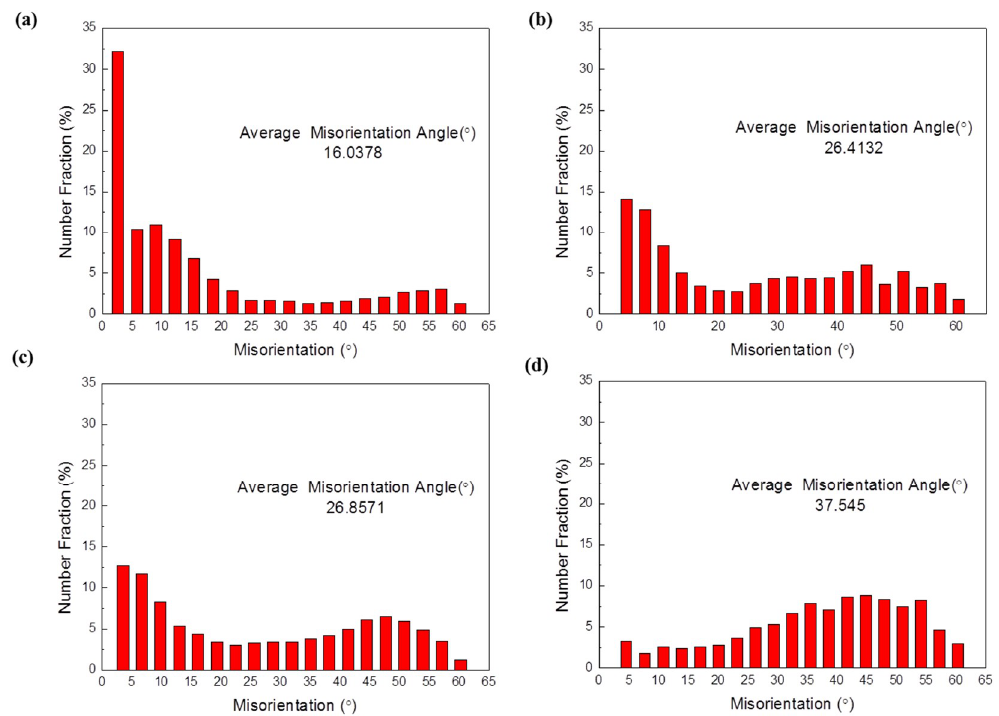
Figure 9. Grain boundary orientation angle distribution of the experimental alloys at different annealing temperatures after 1 h holding. Ce-containing alloy: ( a ) 450 °C; ( b ) 520 °C; Ce-free alloy: ( c ) 450 °C; ( d ) 520 °C.